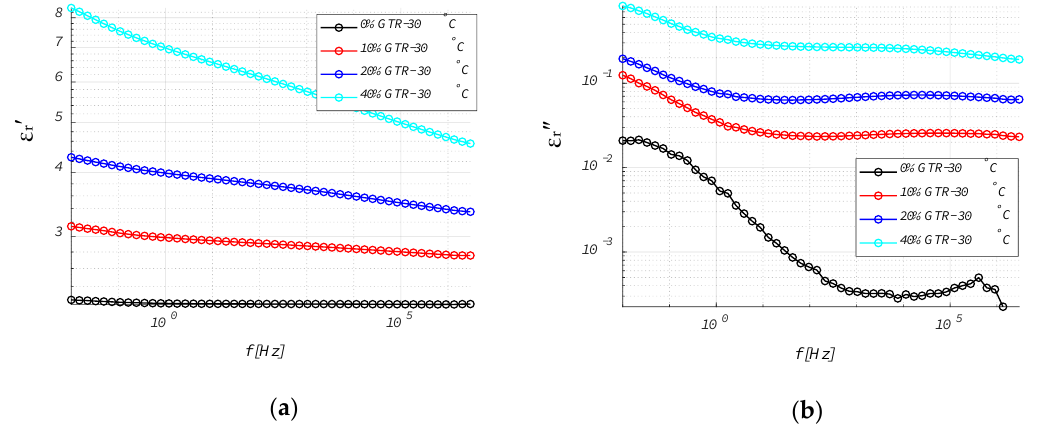
Figure 5. Real ( a ) and imaginary ( b ) dielectric permittivity of HDPE/GTR, at 30 ° C, in relation to frequency: HDPE; HDPE + 10% GTR; HDPE + 20% GTR; HDPE + 40% GTR.